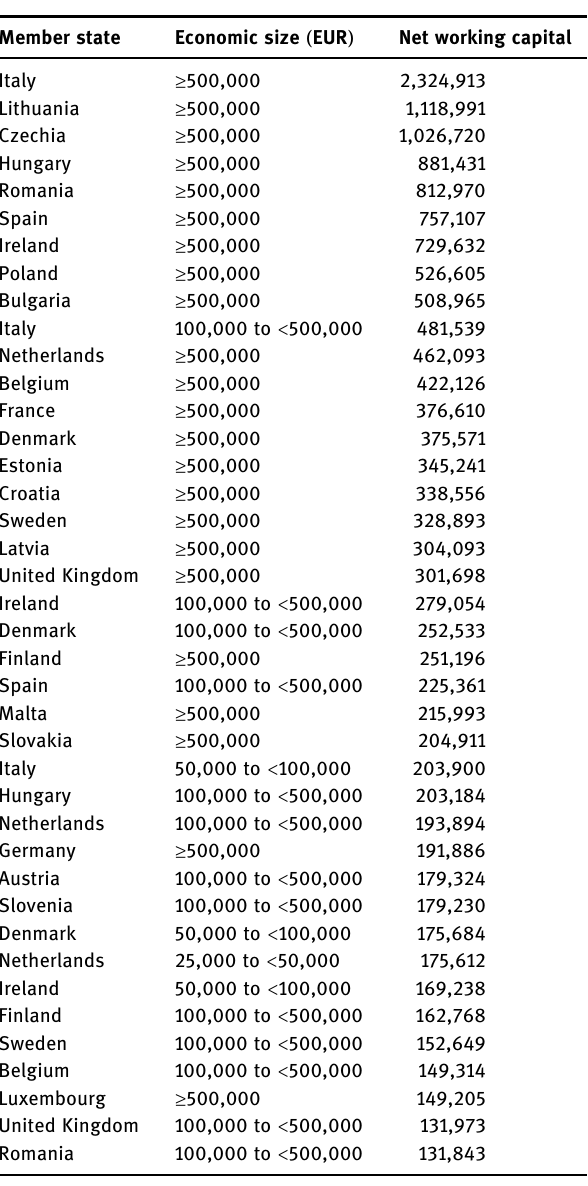
Table 5: Top40 European Union countries ( former 28 ) and economic size for the net working capital ( euros ) on average over the